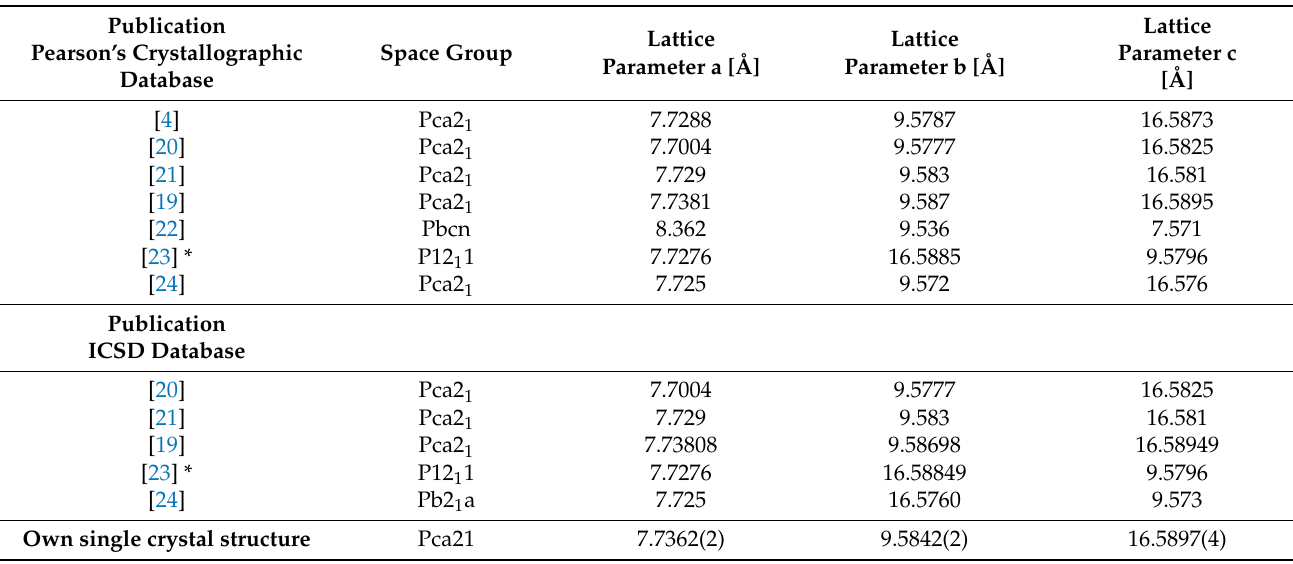
Table 2. Comparison of vanadyl pyrophosphate structure models extracted from Pearson’s crystallographic database, ICSD, and own single-crystal X-ray diffraction structure refinement.